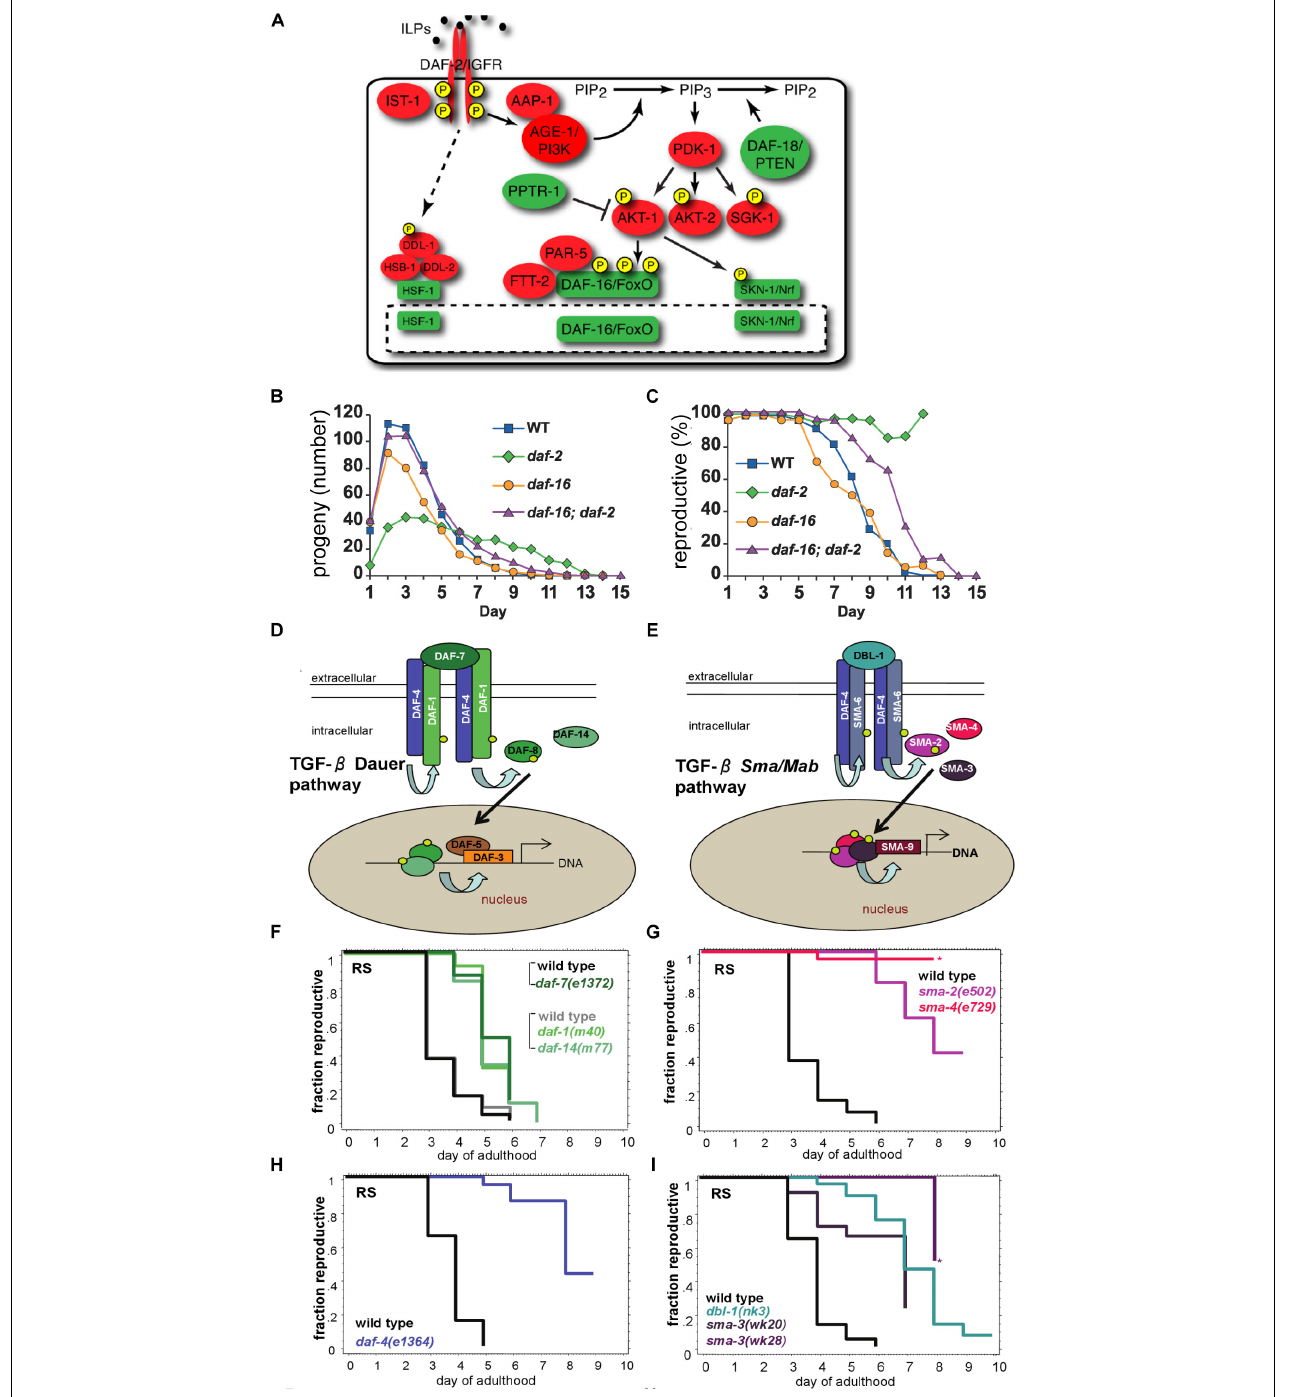
FIGURE 8 | Mutations in the TGF- β and the Insulin/IGF-1 signaling pathways increase reproductive capacity. (A) The schematic depicts the Insulin/IGF-1 signaling pathway. Adapted from Murphy and Hu (2013). (B) Mated hermaphrodites with a mutation in the daf-2 gene (green) display reduced peak progeny number, increased late progeny production, and an extended total reproductive span. By contrast, mated daf-16 mutant hermaphrodites display a reduced peak progeny number, a reduced total progeny number, and a reduced total reproductive span. Adapted from Hughes et al. (2007). (C) Mated daf-2 mutants show a higher percentage of live hermaphrodites producing progeny late in life compared to mated daf-2;daf-16 double mutants, mated daf-16 mutants or mated wild-type animals. Adapted from Hughes et al. (2007). (D,E) The schematics depict the TGF- β Dauer pathway and the TGF- β Sma/Mab pathway. Adapted from Luo et al. (2009). (F–I) C. elegans hermaphrodites with mutations in the TGF- β Dauer pathway (F,H) or TGF- β Sma/Mab (G,I) display an extended reproductive span compared to wild type. Adapted from Luo et al. (2009).